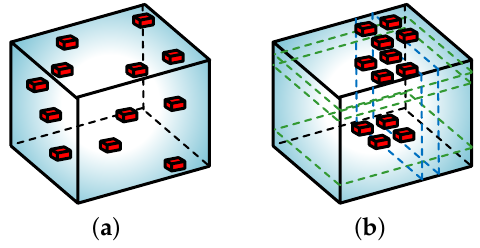
Figure 3. Illustration of different types of sparsity: ( a ) Unstructured sparse core tensor; ( b ) Block- structured sparse core